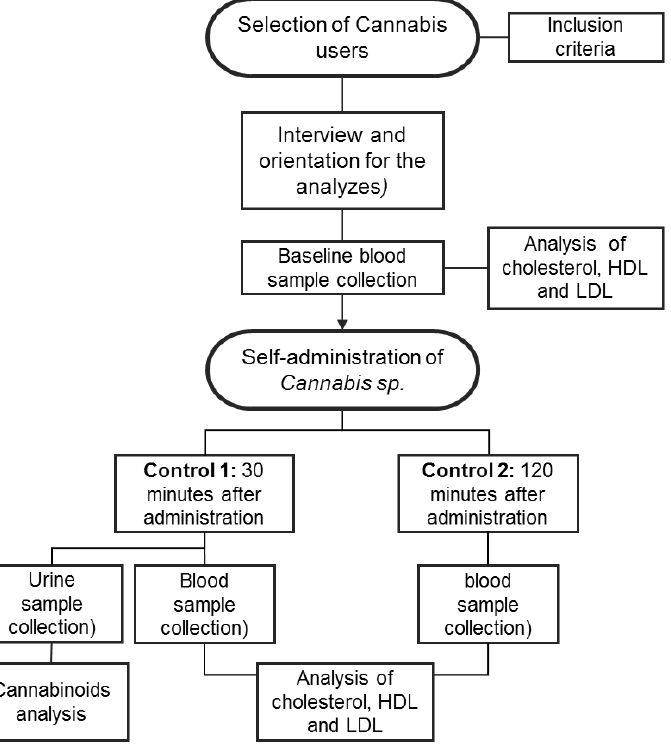
Figure 1. Study flowchart of cannabis effects on cholesterol in Peruvian heavy-users. Patients were assigned a particular hour in the morning for the realization of the project. As part of this workflow (Figure 1), blood samples were collected in Vacutainer tubes with a clot activator and gel (yellow cap) 30 min before self-administration of the test substance. Sample collection followed the sample collection quality criteria described